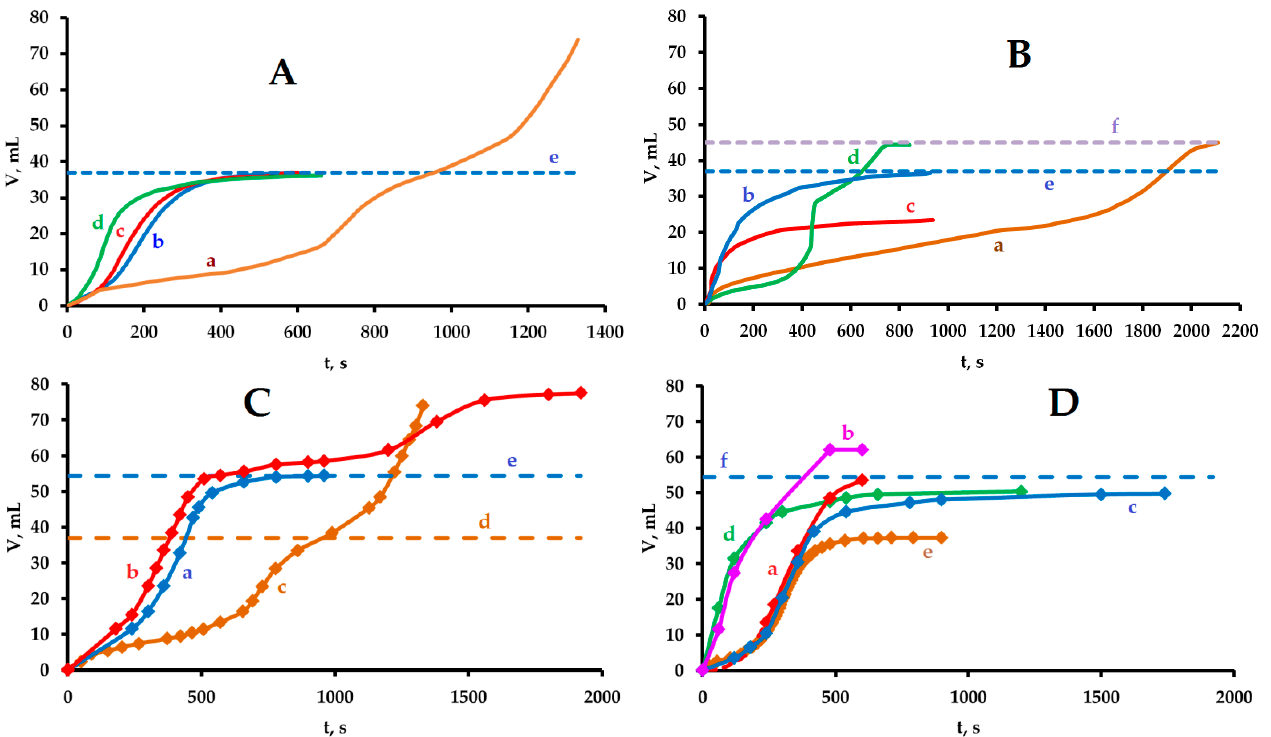
Figure 2. Kinetic curves of gas evolution. Reagent amounts: Cu(II) 40 μ M in all cases, except ( B-d ) (12 μ M); 33% H 2 O 2 0.34 mL (3.3 mM) in ( A , B , C-c ) and 0.5 mL (4.9 mM) in the other cases; acetonitrile 5 mL in all cases, hydrocarbon RH 7 (0.1 mL, 830 μ M) ( D ). Catalysts: Cu 2 Cl 4 · 2DMG ( A-a , A-b , C , D ), CuCl 2 · 2H 2 O + DMG (1:1 mMs) ( A-c ), CuCl 2 · 2H 2 O ( A-d ), Cu(DMG-H) 2 ( B-a ), Cu(DMG-H) 2 + CuCl 2 · 2H 2 O + HCl (1:1:2 mMs) ( B-b ), CuO · CuCl 2 (Cu 2 OCl 2 ) ( B-c ), CuO ( B-d ). The stirring speed is 400 revolutions per minute for all cases except ( D-a , D-b , D-d ) (correspondently 0, 200, 600 revolutions per minute). The reaction temperature was 50 °C. In experiment C-b , the reaction solution was kept for 10–15 min in the reactor before adding the catalyst. Equations of straight lines: V = 37 mL ( A-e , B-e , C-d ); V = 45 mL ( B-f ); V = 54.4 mL ( C-e , D-f ).